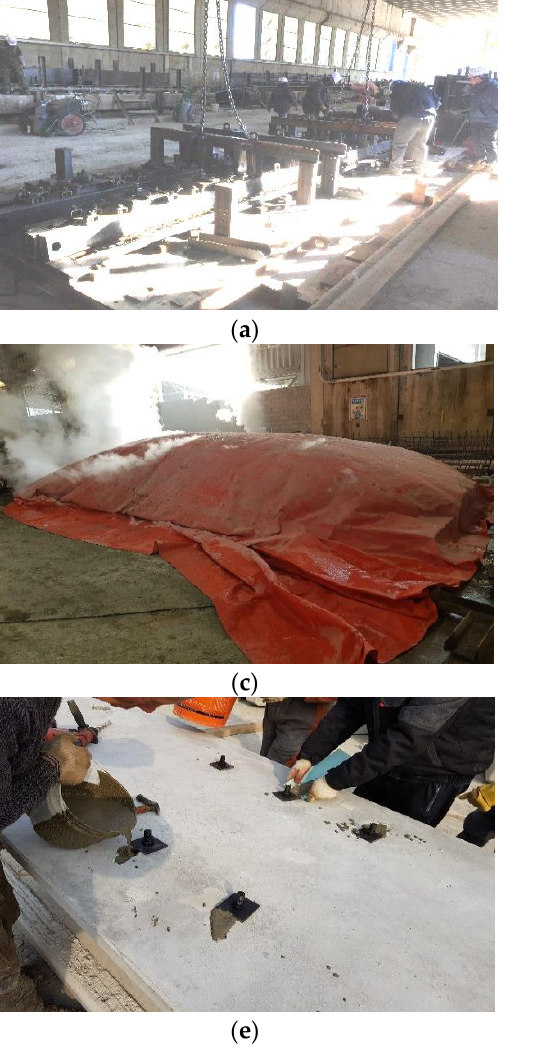
Figure 4. Fabrication process of DCW specimens: ( a ) formwork; ( b ) casting precast concrete; ( c ) steam curing; ( d ) assembling panels using bolts; ( e ) grouting; ( f ) pouring cast-in-place (CIP) concrete.